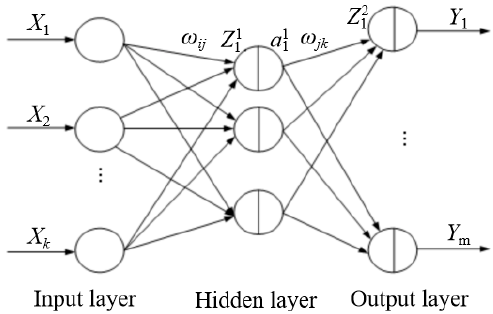
Figure 9. Structure of wavelet neural network.